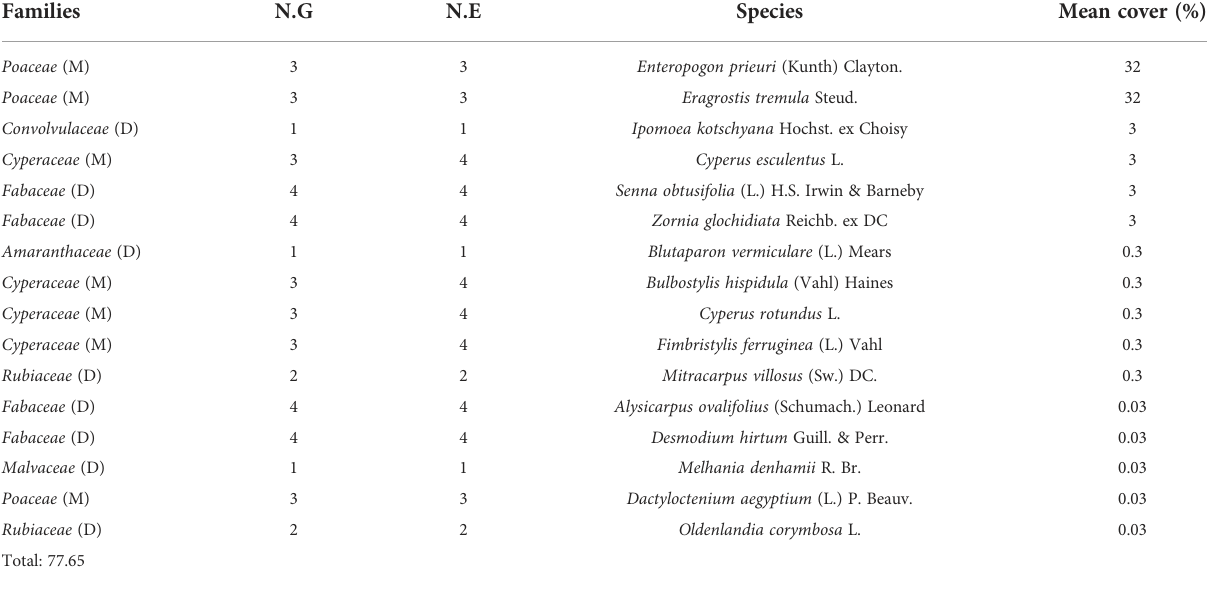
N.G, number of genders; N.E, number of